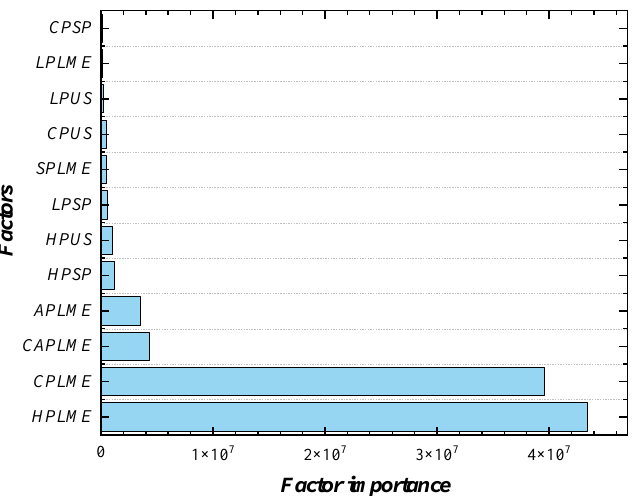
Figure 5. The rank of factor